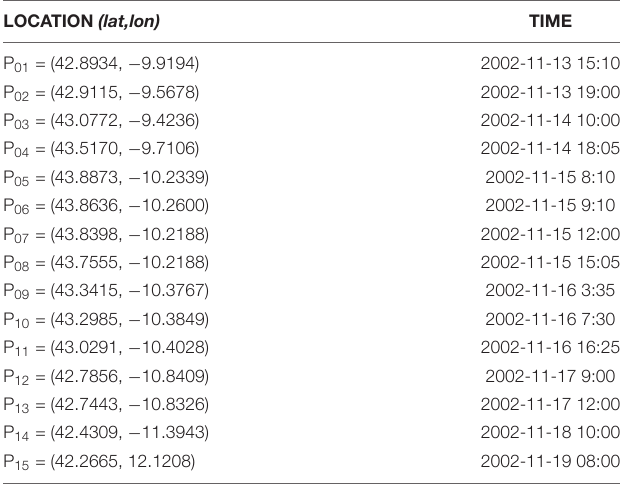
TABLE 1 | The list of the Prestige’s positions reported by the Bahamas Maritime Authority Report from the initial spill to its final breaking up. LOCATION (lat,lon)